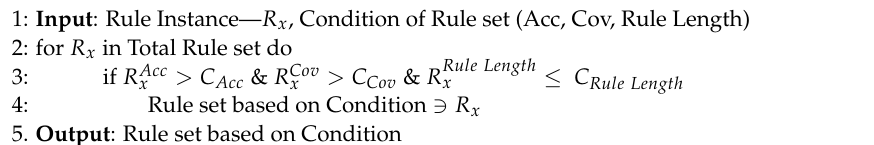
Figure 4. Decision Tree Structure. Algorithm 1 Rule Set Filtering